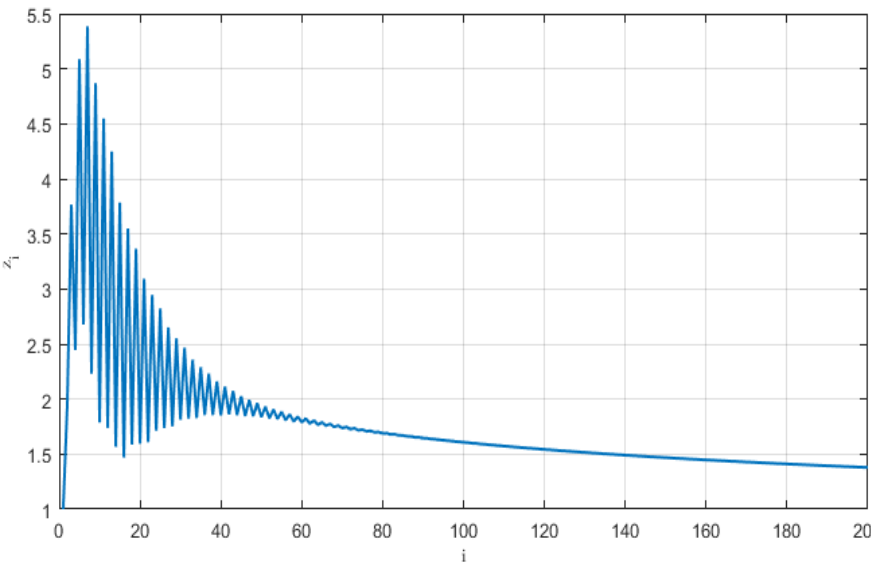
Table 1. The mean values of the condition numbers of the matrices and their standard deviations.